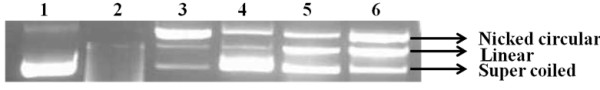
Effect of seed and leaf extracts of A. moschatus on the integrity of pBR322 plasmid DNA in the presence of Fenton's reagents. (Lane 1: pBR322 DNA + H2O; Lane 2: pBR322 DNA + FR; Lane 3: standard antioxidant compound (quercetin) in the presence of FR; Lane 4: pBR322 DNA + FR + AMS-IV; Lane 5: pBR322 DNA + FR + AML-IV; Lane 6: pBR322 DNA + FR + AML-I).